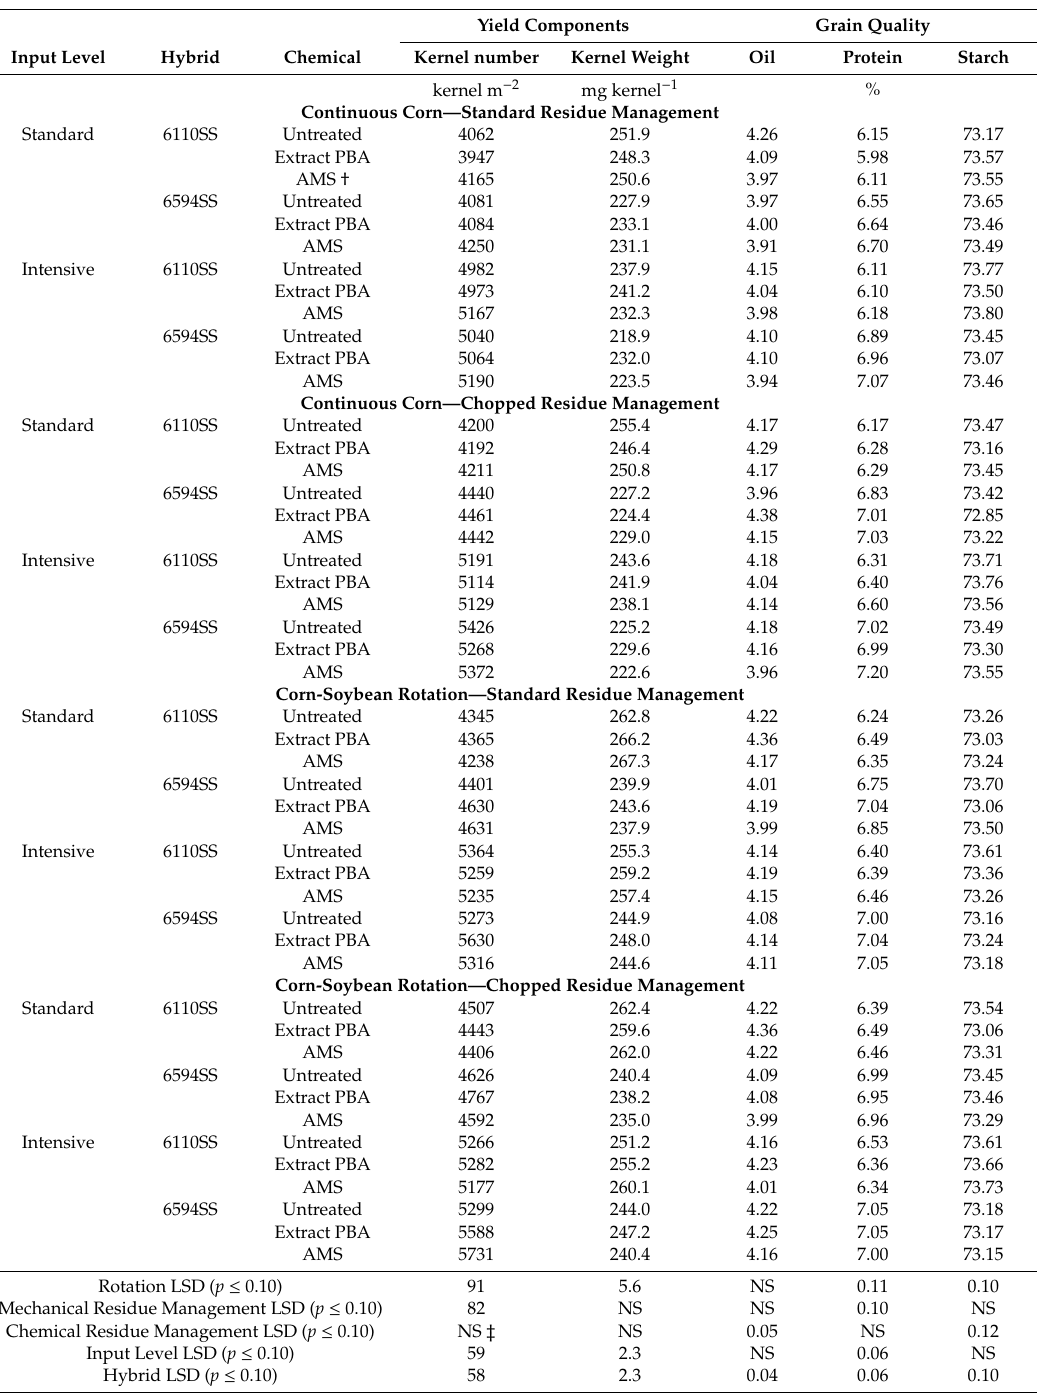
Table 9. Yield components and grain quality as influenced by crop rotation, mechanical and chemical residue management, input level, and corn hybrid when grown at Champaign, IL during 2017 and 2018. All values are reported at 0 g kg − 1 moisture